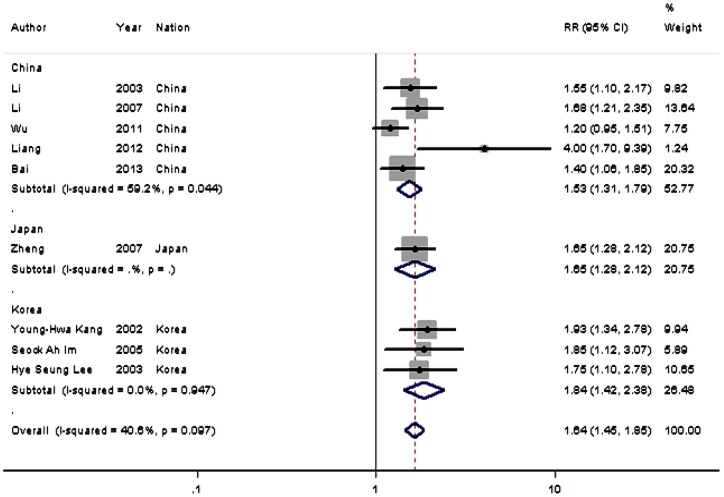
Meta-analysis on the relation between PTEN expression and 5-year overall survival (OS).The summary RR and 95% CIs were shown (fixed-effect model analysis).